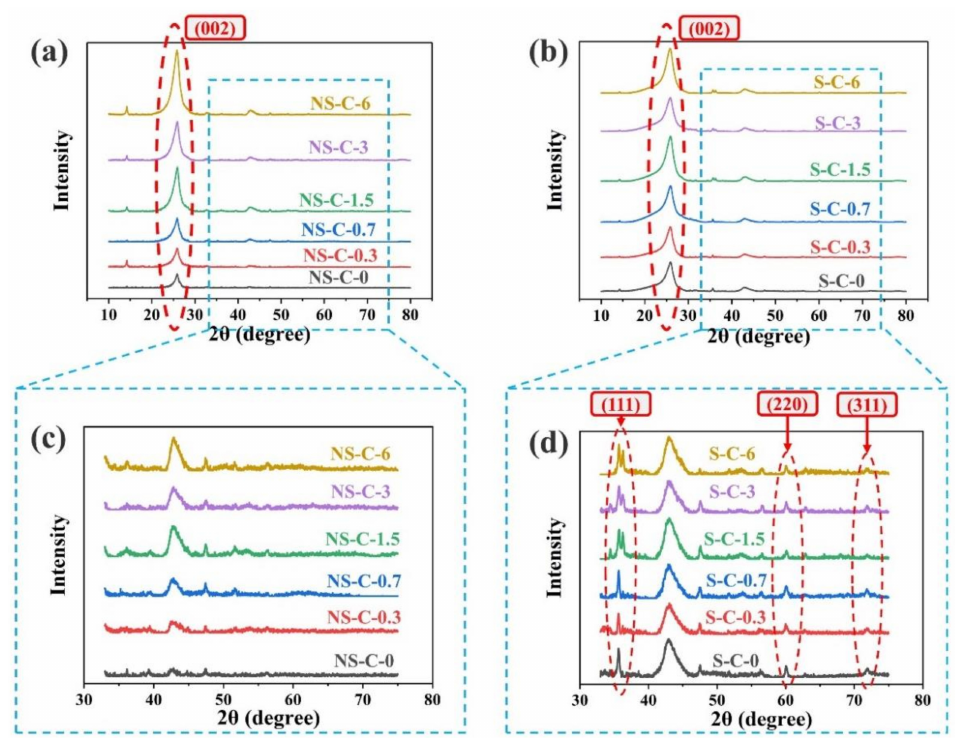
Figure 5. Effects of MWCNTs content on the X-ray diffraction profiles of char layers: group NS ( a , c ) and group S ( b , d